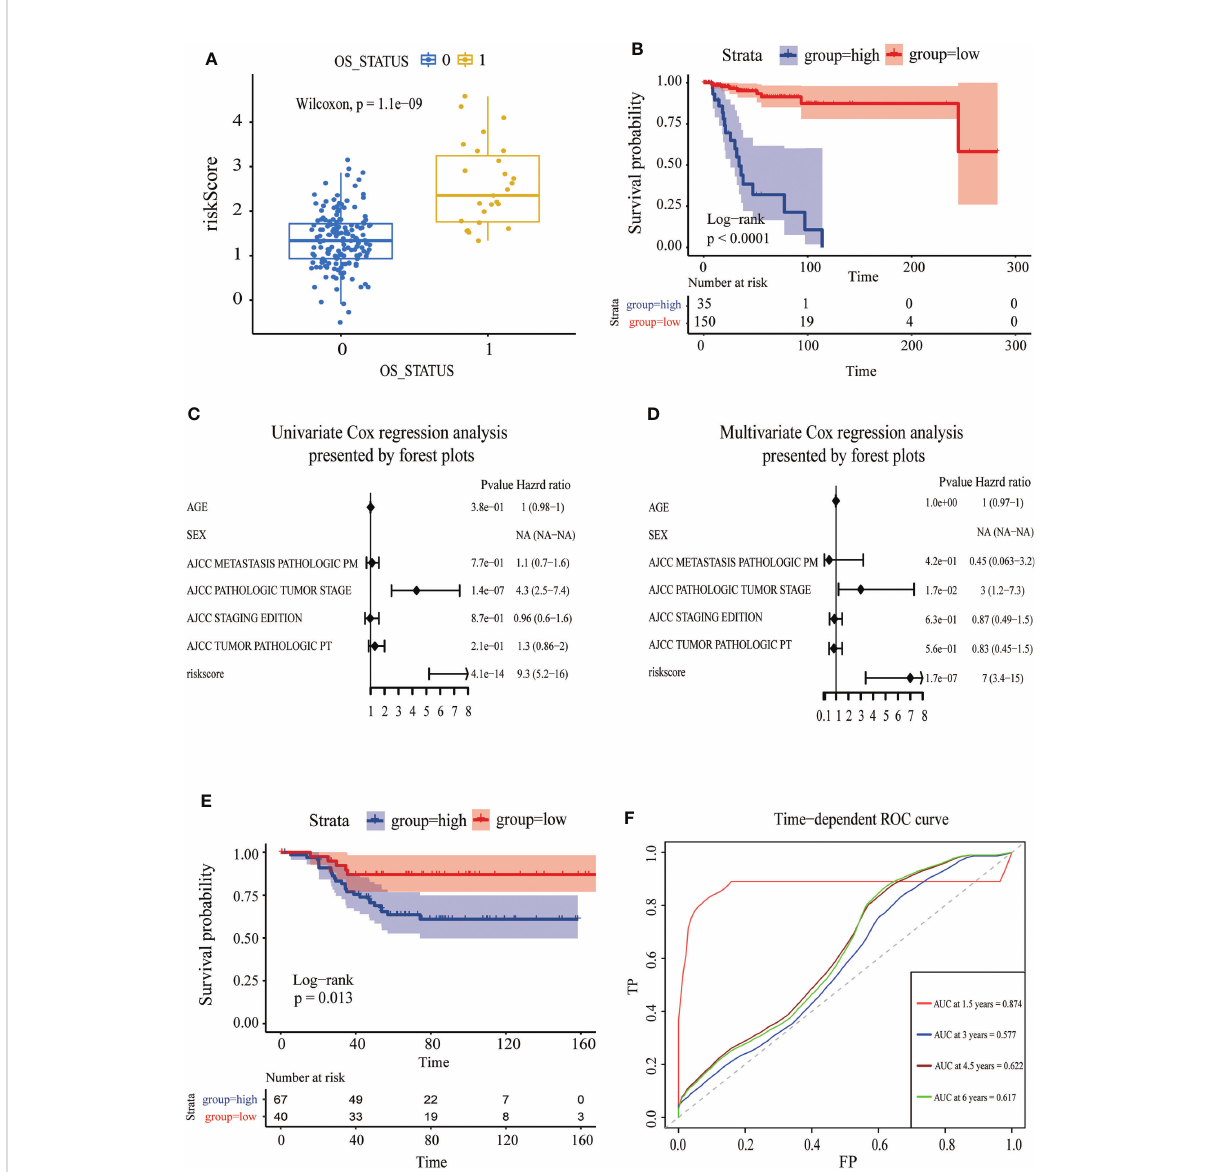
FIGURE 6 Assessment of the independent prognostic value and validation of CDKN2A-derived prognostic model of TNBC. (A) The correlation between OS status and risk score. (B) The survival curve of high and low risk score in TNBC. (C) Univariate Cox regression analysis of CDKN2A-derived prognostic model. (D) Multivariate Cox regression analysis of CDKN2A-derived prognostic model. (E) The survival curve veri fi ed by the external validation set. (F) The time-dependent ROC curve and AUC values respectively at 1.5 years, 3 years, 4.5 years, and 6 years veri fi ed by an external validation